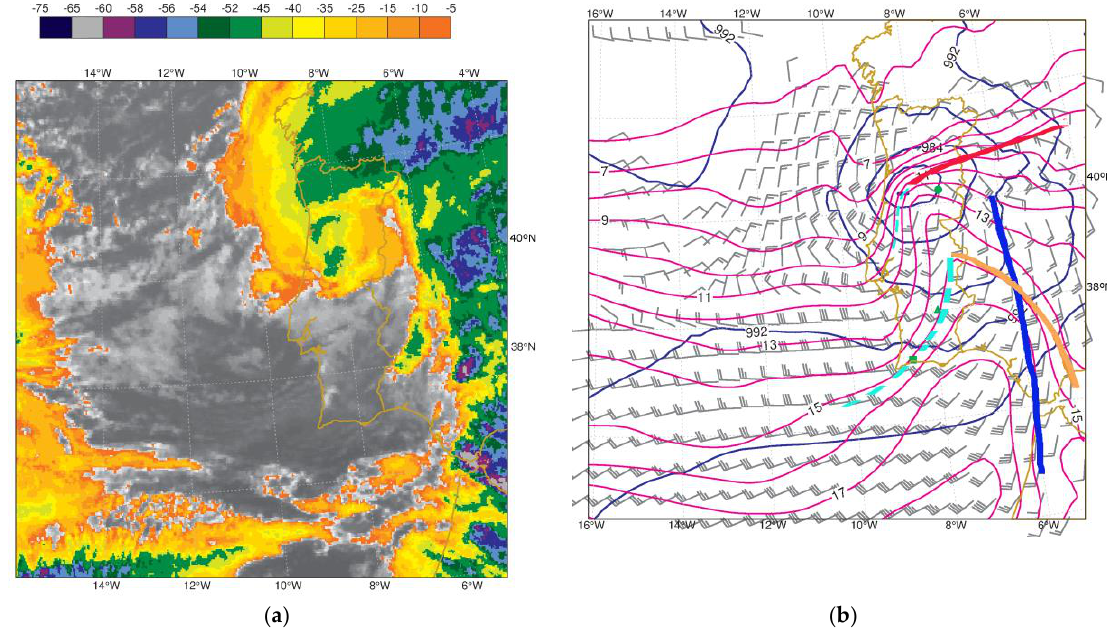
Figure 17. ( a ) IR10.8 brightness temperature (shaded from −5 to −75 °C) at 06:00 UTC. ( b ) 10-m wind (dark grey barbs) and 925 hPa θ w (1 °C intervals from 6 to 18 °C in magenta lines) from ECMWF. The cold front and the secondary cold front are depicted by cyan dashed lines. The approximate locations of WF1, WF2 and UCF are marked by orange, red and blue lines. The frontal analysis is based on data from ECMWF, satellite and weather stations.